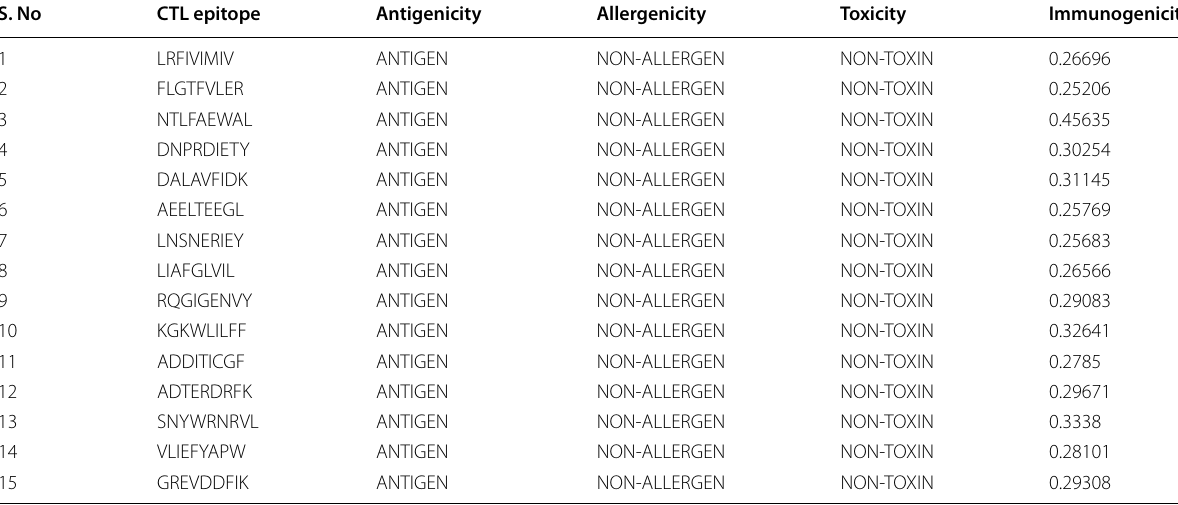
Table 1 Results of the finally shortlisted CTL epitopes